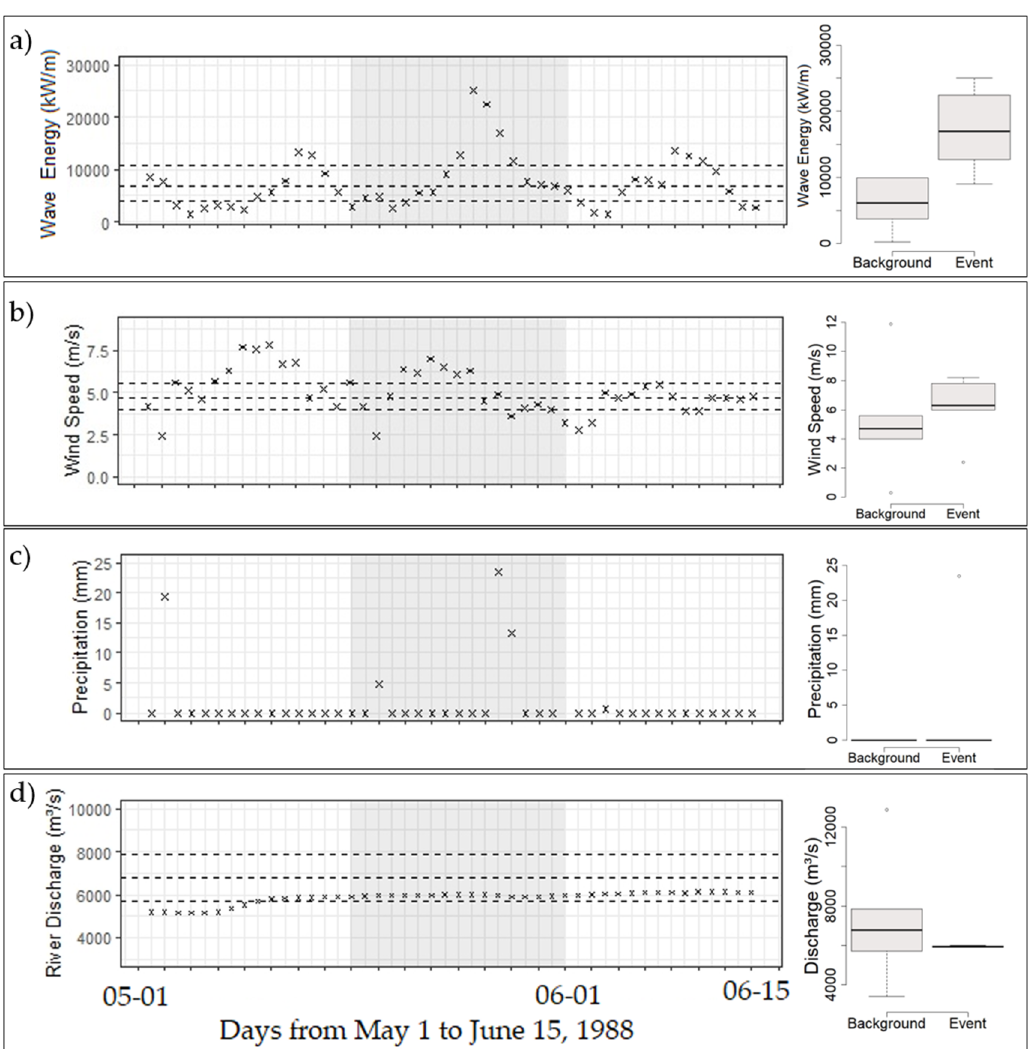
Figure 7. Time series of potential drivers of a lagoon breaching in May 1988. The left panels indicate daily maximums for ( a ) wave energy, ( b ) wind speed, ( c ) precipitation, and ( d ) the Magdalena River discharge. Dashed lines show the 25th, 50th, and 75th percentiles for non-event conditions (background), and crosses indicate the conditions before, during (grey shaded area), and after a breaching event. Box plots on the right panels help visualize DBM/OVS ratios reported in Table 1.